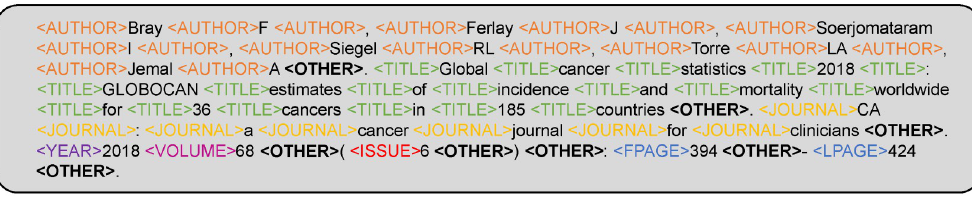
Fig 2. Example of a sequence of labeled tokens for a reference string. After tokenizing a reference string, each token is assigned specific labels. The tokens related to the metadata are assigned the labels for metadata field types. Other tokens not related to the metadata are assigned the “other”